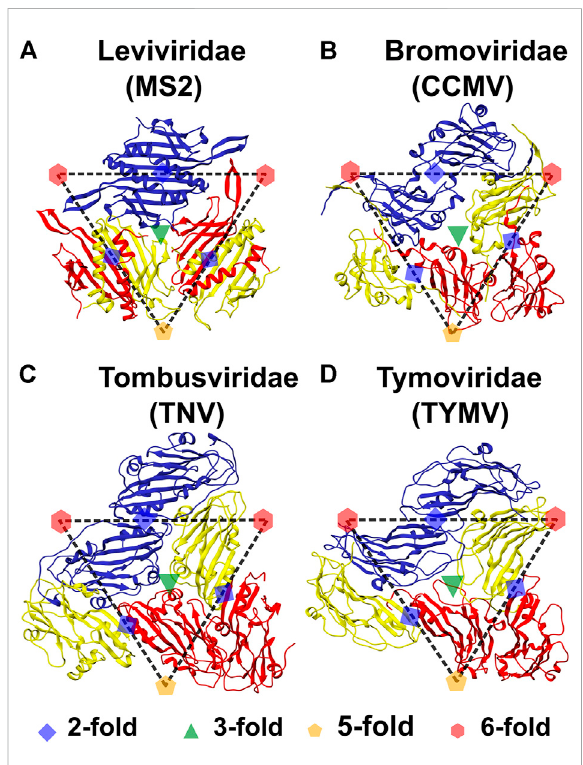
FIGURE 2 Symmetryelementsinthetri-dimerstructuresofrepresentatives fromthefourvirusfamilies.Thestructuresarelabeledbyboththevirus family and the virus name. All (quasi-)rotation symmetry axes can be shownusingthedimersofthethreemonomers,termedA,Band C and approximately bounded by the dashed triangle, that form the Icosahedral Asymmetric Unit. In all four viruses, chains A, B and C are colored red, yellow and blue, respectively. The position of the axes of rotationsymmetry aremarked.Thegreentriangleatthecenter of the IAU represents the QC 3 symmetry axis and any pair of CPs within the IAU form the trimerization interface (Figure 1E). Red hexagons and orangepentagons represent QC 6 andC 5 symmetry axesrespectively. Five A conformers are present around the C 5 axes (Figures 1A,B) of which two are present in the tri-dimer and they form the pentamerization interface (Figure 1F). Alternating B and C conformers (threeeach)arepresentattheQC 6 axes(Figures1A,B)ofwhichoneB and one C conformer can be seen at each of the two QC 6 axes and these form hexamerization interfaces (Figure 1G). A blue diamond betweenthetwoCCPchains(presentinadjacentIAUs)indicatesaC 2 axis, while those between the A CP and B CP chains present in adjacentIAUs,indicateQC 2 symmetryaxes.Theinteractionsbetween these dimers, termed CC CP2 and AB CP2 respectively, form the dimerization interface (Figure 1D). (A) Bacteriophage MS2 (MS2), (B) Cowpea Chlorotic Mottle Virus (CCMV; also see Figure 1C), (C) Tobacco Necrosis Virus (TNV) and (D) Turnip Yellow Mosaic Virus (TYMV). The chains (conformers) are named as in their PDB fi les. It should be noted that the A and B names are fl ipped in MS2 as comparedtothejelly-rollviruses,withtheBconformerbeingpresent in the pentamer and the A conformer in the hexamer. Tri-dimeric structures from each virus were used to calculate all the CP-CP interactions. Structures generated using UCSF Chimera (Pettersen et al.,